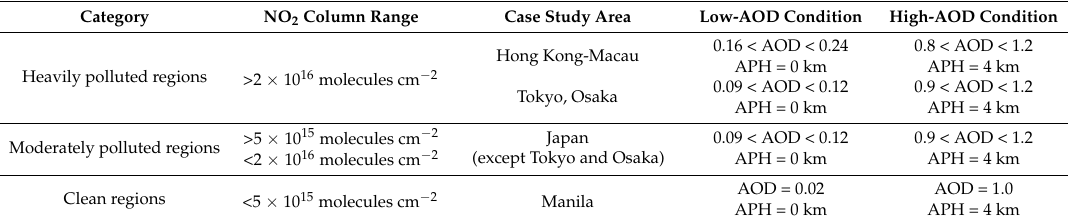
Table 2. NO 2 column range and case study areas in heavily polluted, moderately polluted, and clean regions, along with AOD and APH ranges used to calculate AMF and synthetic radiances under low- and high-AOD conditions. (Aerosol optical depth (AOD), aerosol peak height (APH) and air mass factor (AMF)). Category NO 2 Column Range Case Study Area Low-AOD Condition High-AOD